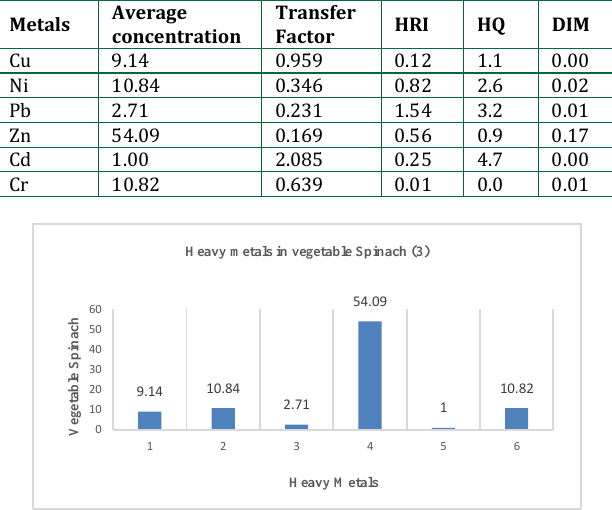
Table 18: Heavy metal Concentration in Vegetable Spinach (3).